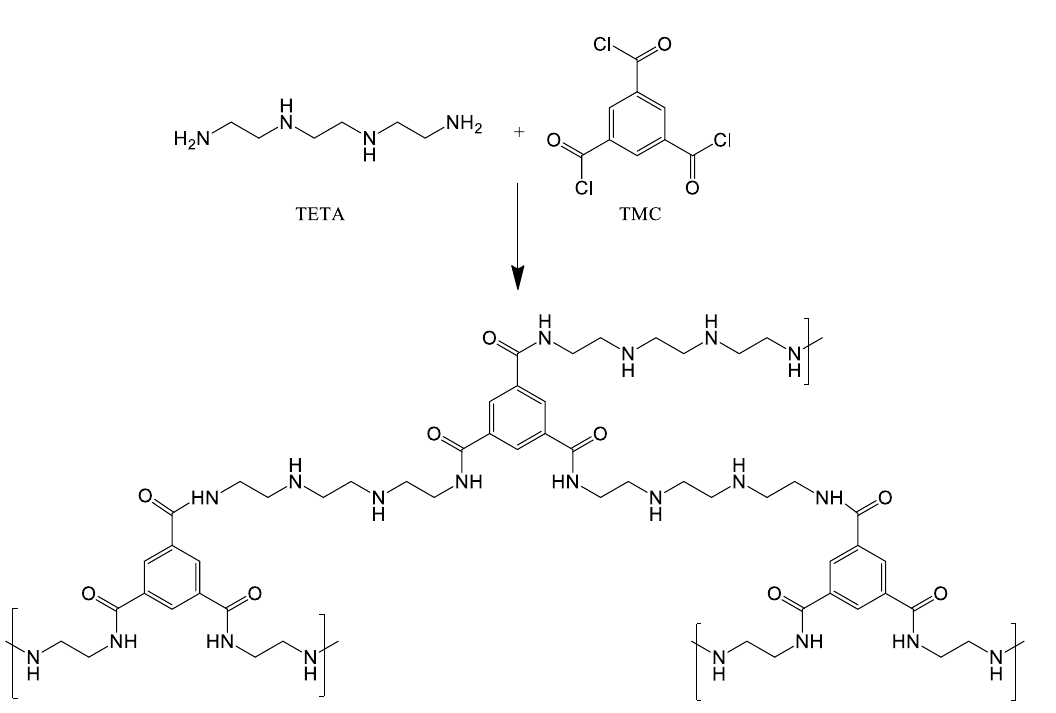
Figure 1. Reaction between TETA and TMC in the interfacial polymerization.